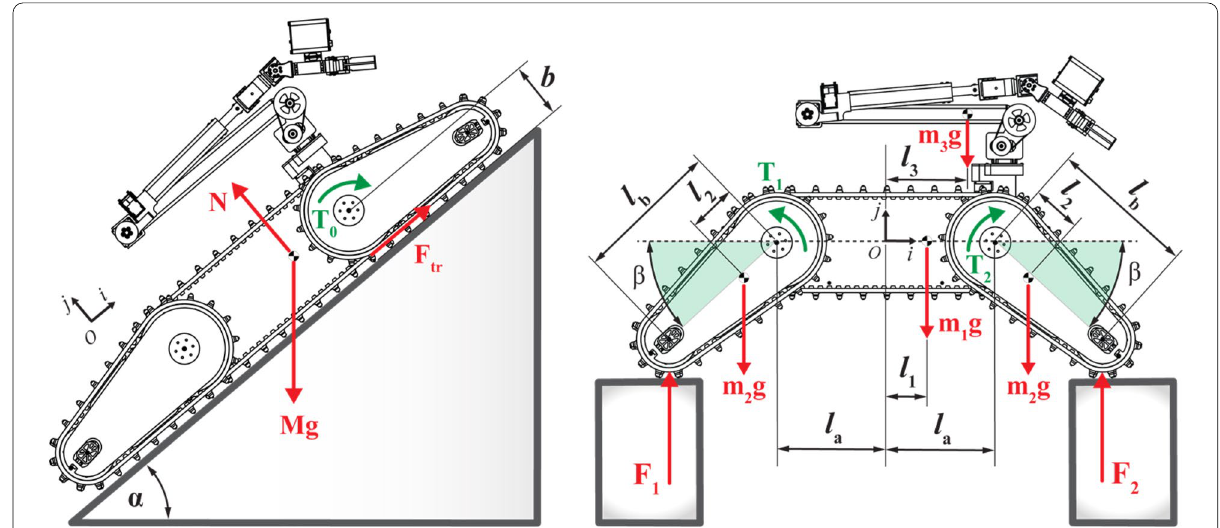
Fig. 8 Free body diagram of Karo climbing a 40° ramp (left) and lifting the robot on the gap by using flippers